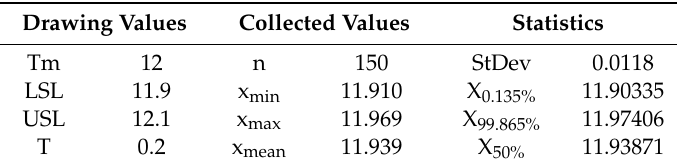
Table 7. Process capability analysis for the H dimension.